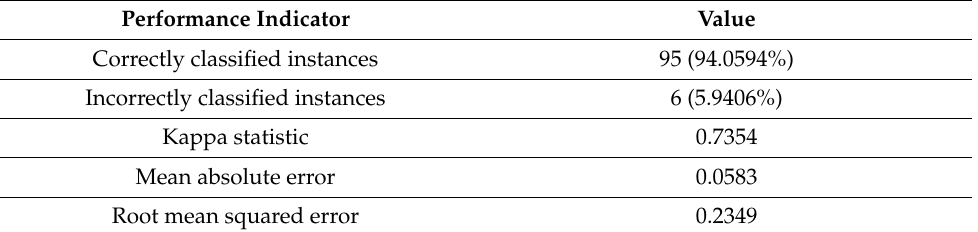
Table 12. Performance indicators recorded by the C4.5 algorithm in the evaluation of diabetic retinopathy.